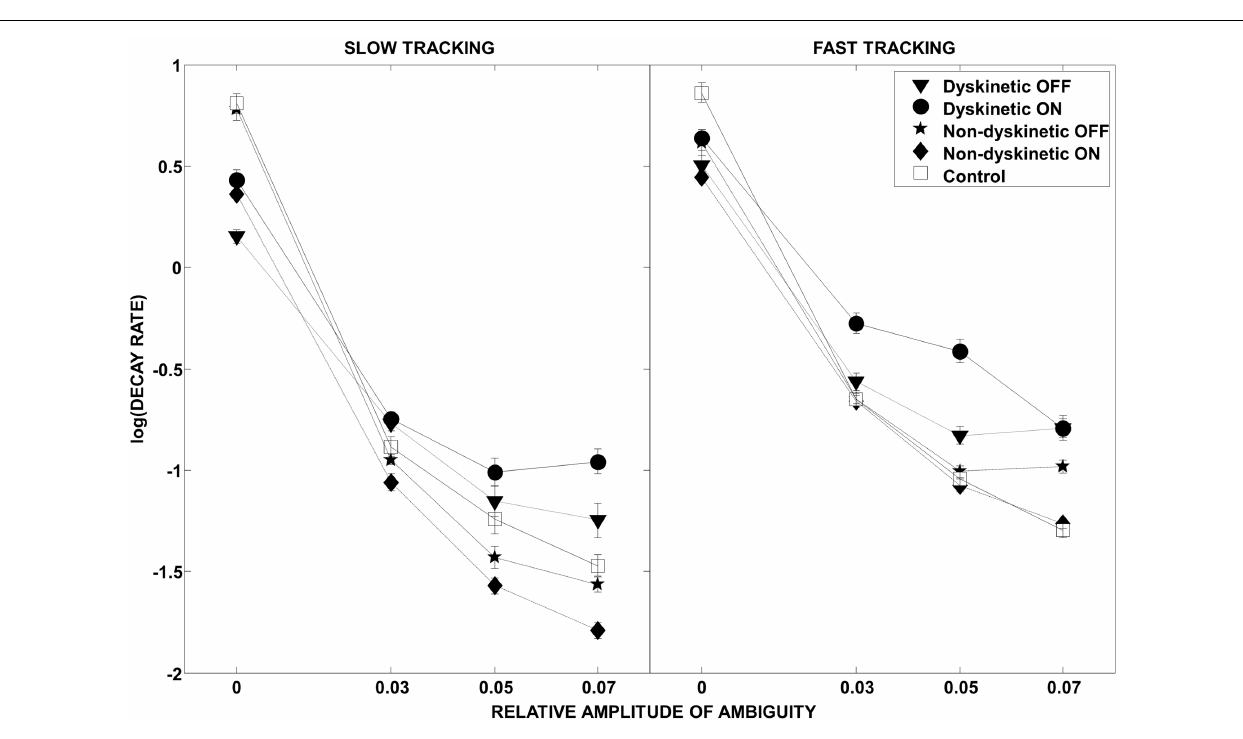
FIGURE 4 | Log(decay rate) as a function of visual ambiguity and tracking speed . Differences in RMS error in the low tracking speed condition (left panel) and high tracking speed condition (right panel) are shown. Error bars were estimated by leave-one-out-validation.